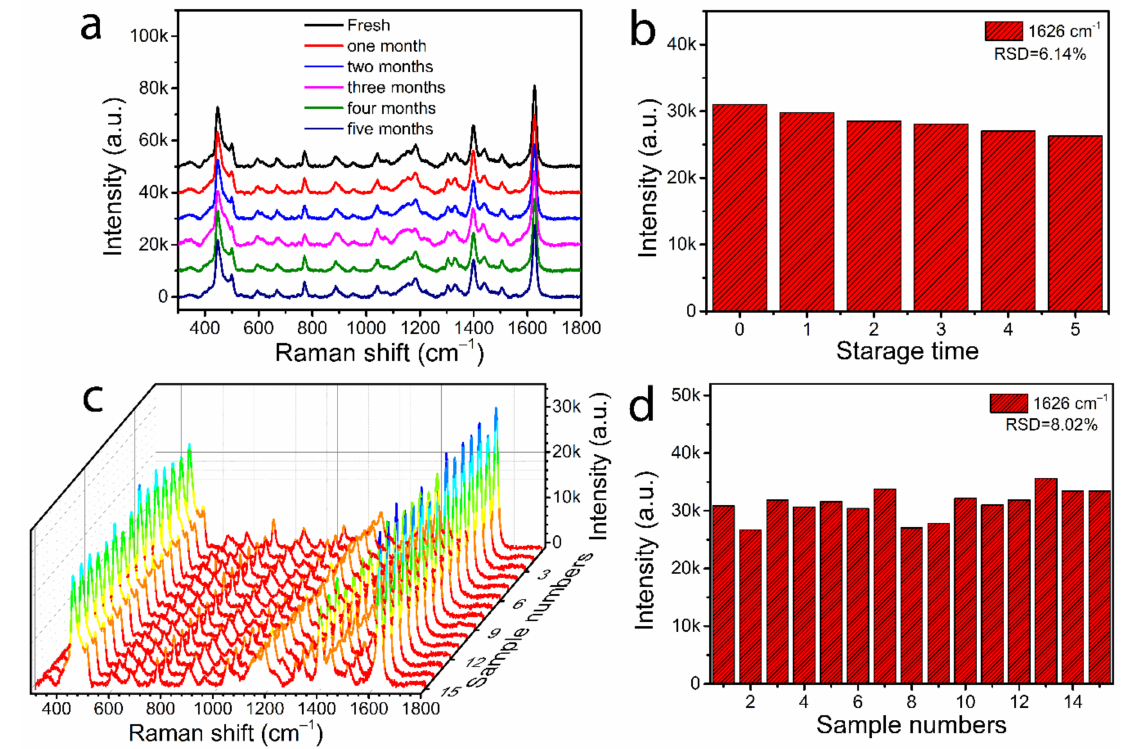
( a ) SERS spectra obtained by employing 10 − 5 M MB on the fresh hydrophobic CFP@PDA@AuNPs and the variations with extended storage time. ( b ) Analysis of the intensity for the feature peak at 1626 cm − 1 with increasing preservation time. ( c ) Waterfall graph of MB (10 − 5 M) SERS signals recorded from 15 various samples. ( d ) Corresponding histograms of peak intensity at 1626 cm − 1 for 15 different